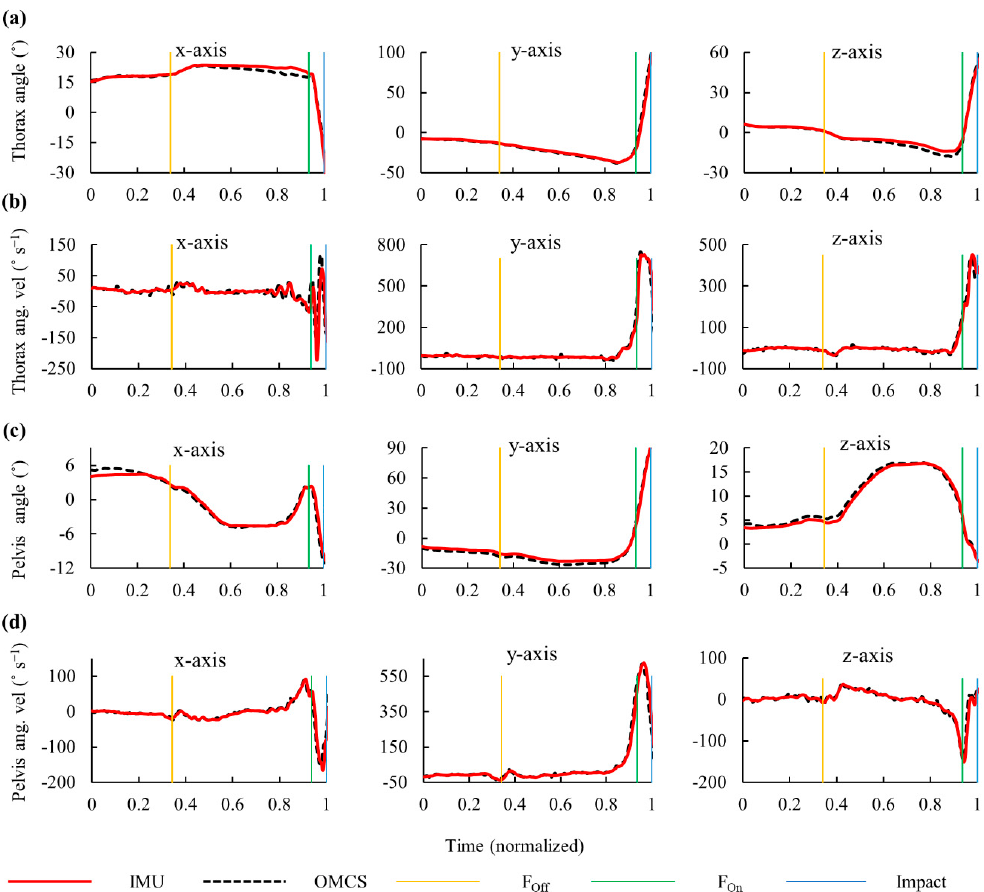
Figure 4. Typical graph of time-dependent change in angular displacement and angular velocity (ang. vel.) of the thorax (( a ) and ( b )) and pelvis (( c ) and ( d )) segments measured using the inertial measurement units (IMUs) and the optical motion capture system (OMCS). Vertical lines represent foot-off (F off ), foot-on (F on ), and impact events.